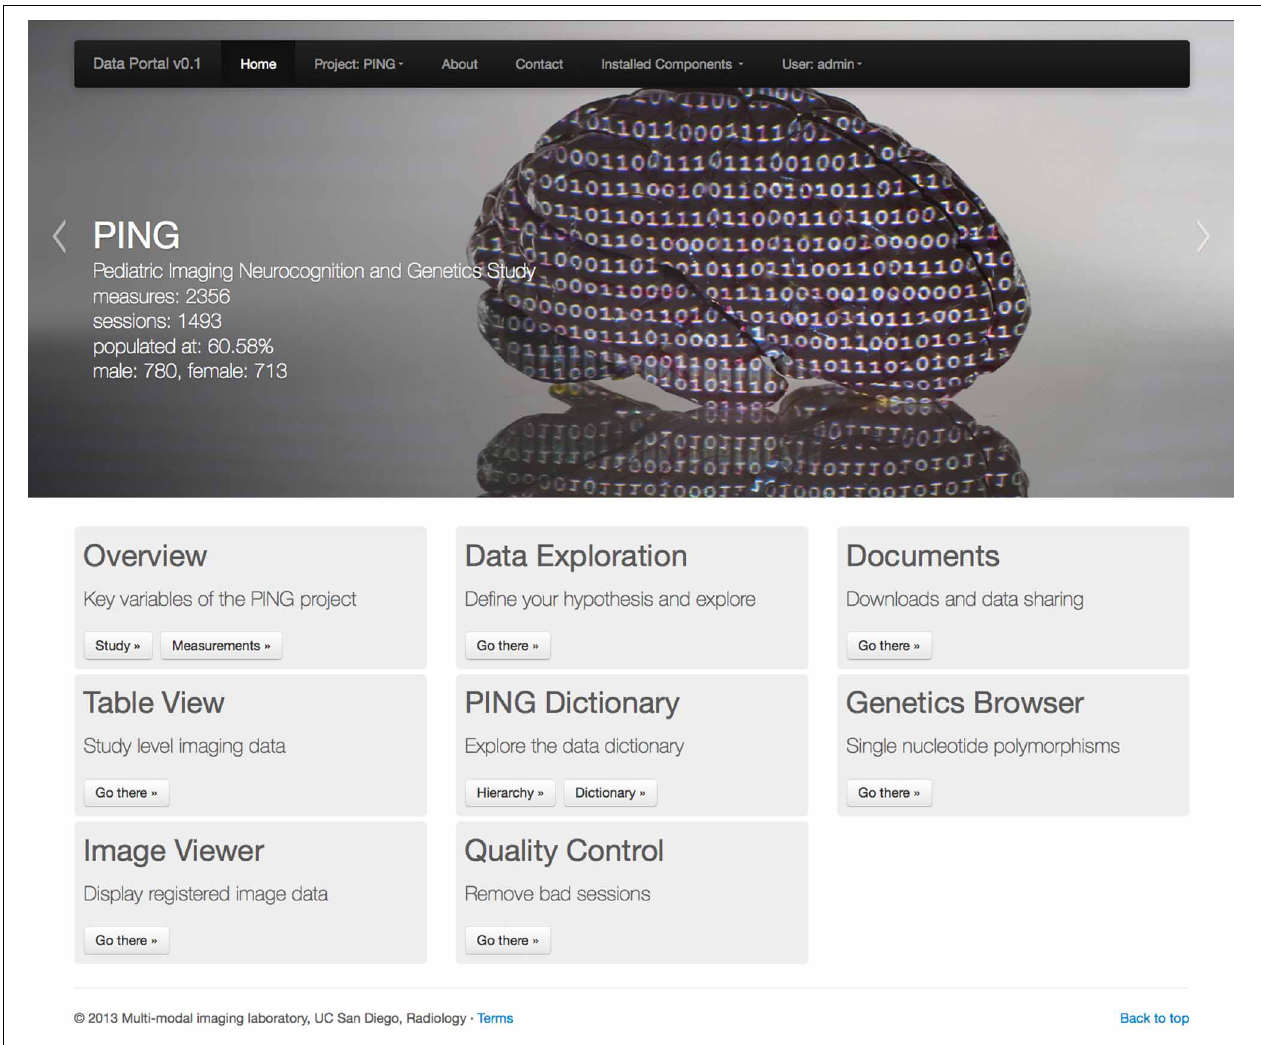
FIGURE 1 | Entry page to the PING data portal reflecting the architecture of the data portal as a collection of workflow driven components. A navigation menu structure and project data summary is